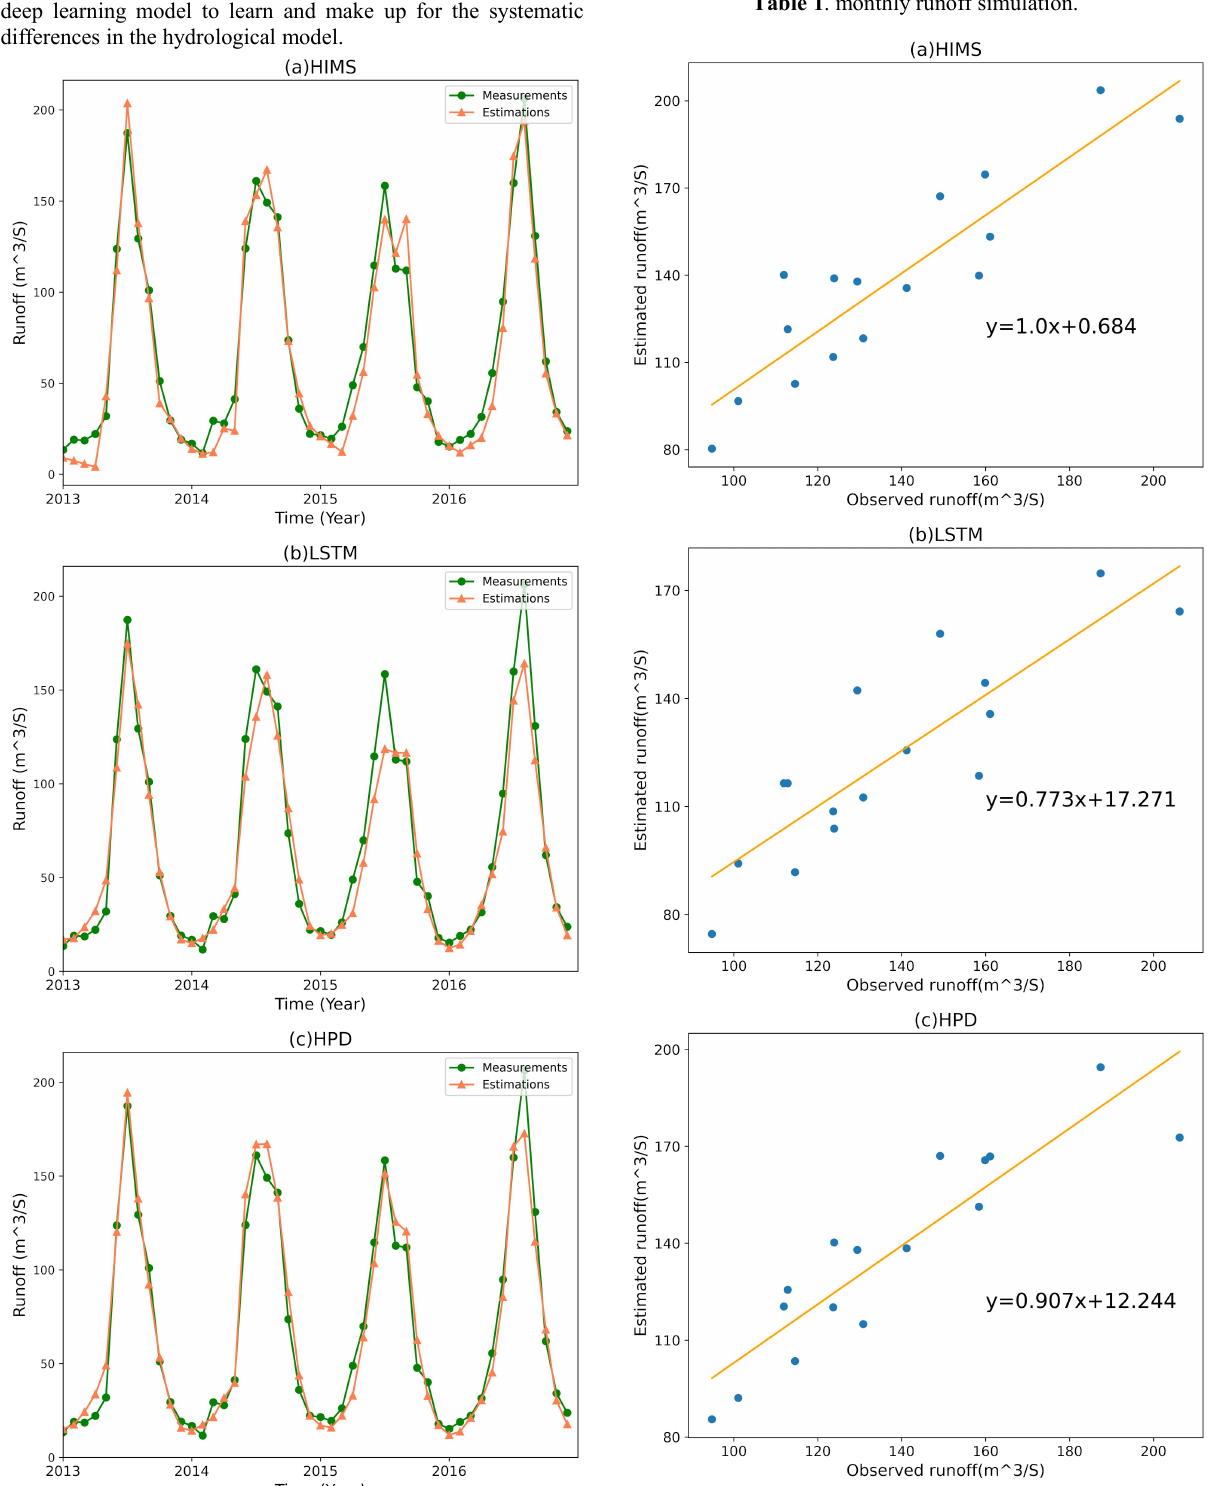
Figure 4 . three kinds of runoff estimation in flood